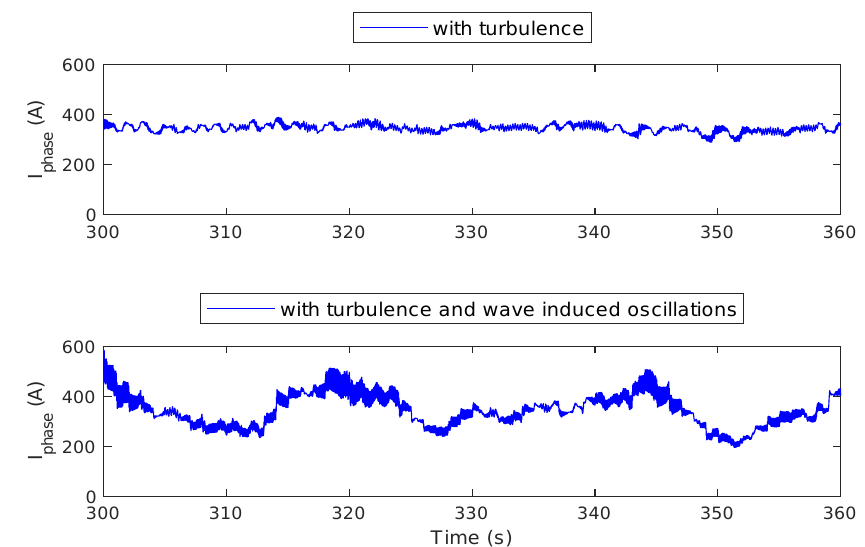
Figure 17. Generator phase currents (rms values). The variations in the phase current value are a direct consequence of the generator speed variations in Figure 16. This also illustrates why an IGBT module with 600 A rating was selected in this paper. The above graph would have depicted a flat line (about 380 A) without any velocity oscillations.